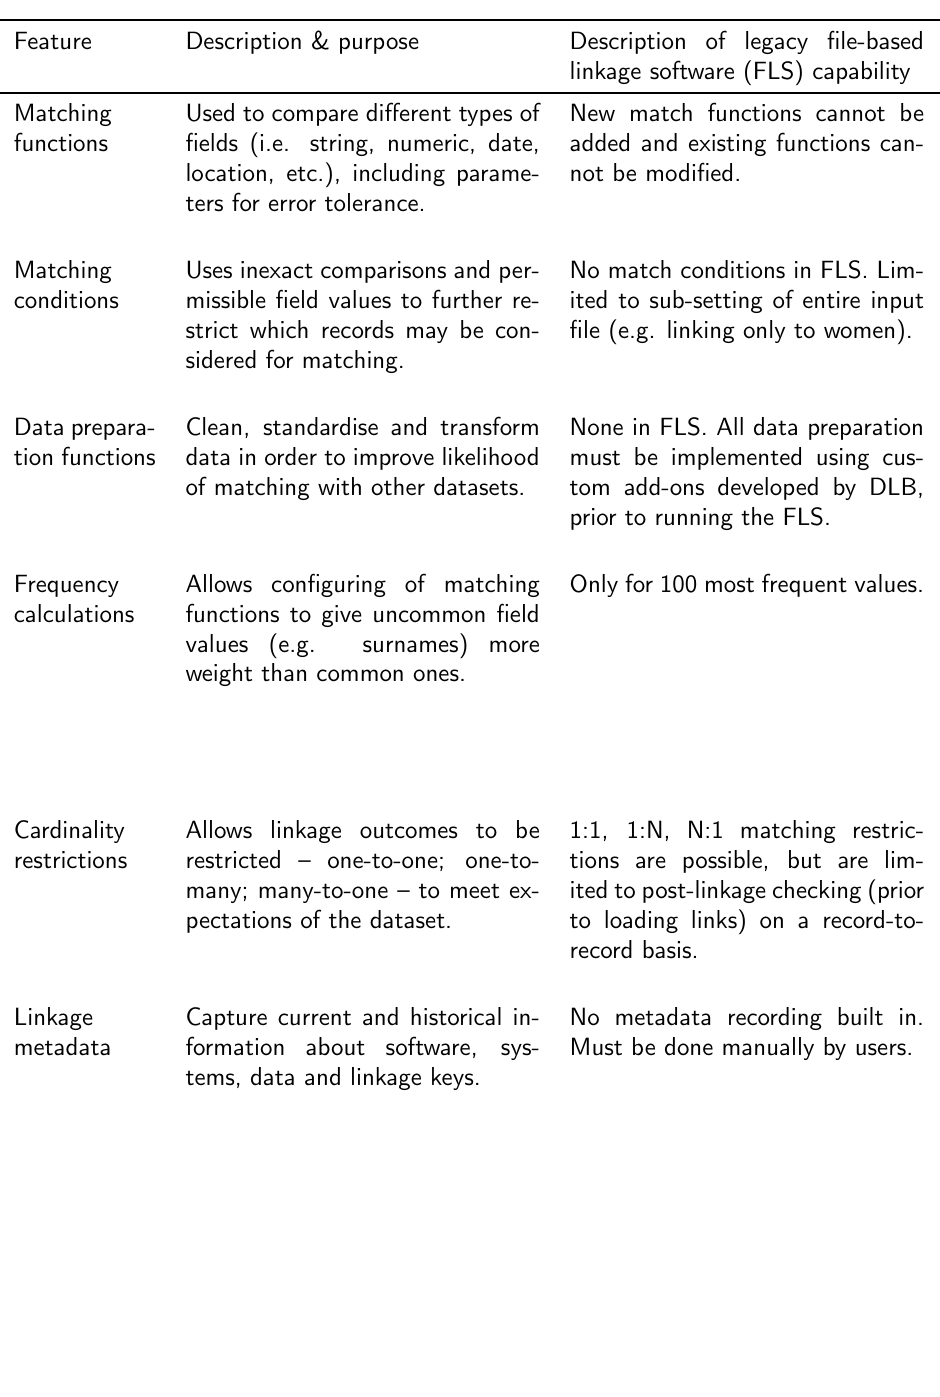
Table 4: Matching features added or enhanced in the new data linkage system